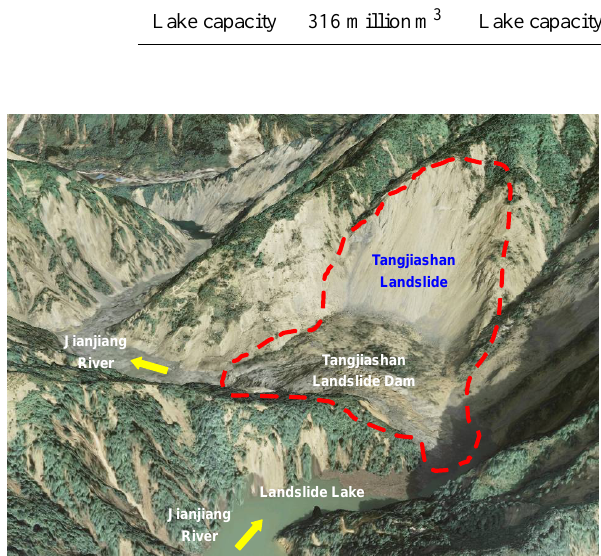
Fig. 1. Satellite image of the Tangjiashan landslide triggered by the 2008 Wenchuan earthquake (modified from Liu, 2008)